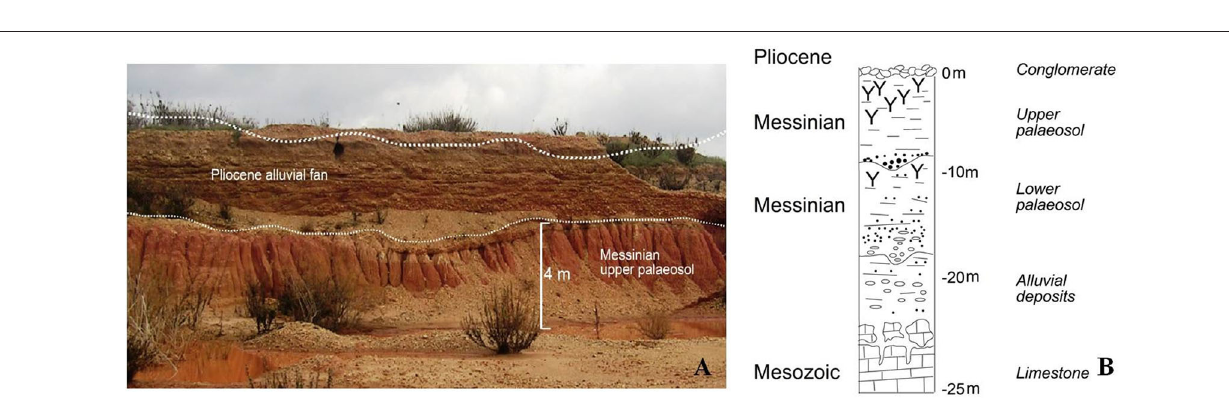
FIGURE 3 | (A) Continental deposit comprising channelized gravel and clay-rich horizons displaying evidence of pedogenesis (modified after Mongelli et al., 2015). (B) Sketch of the stratigraphy of the MP